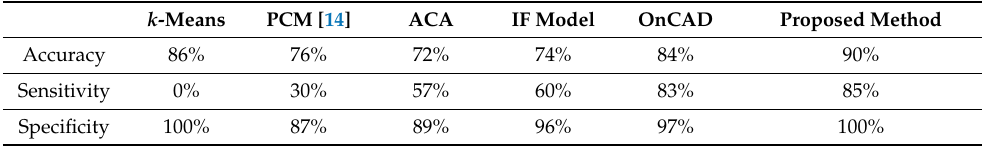
Table 3. Comparative analysis using Kitsune in terms of different